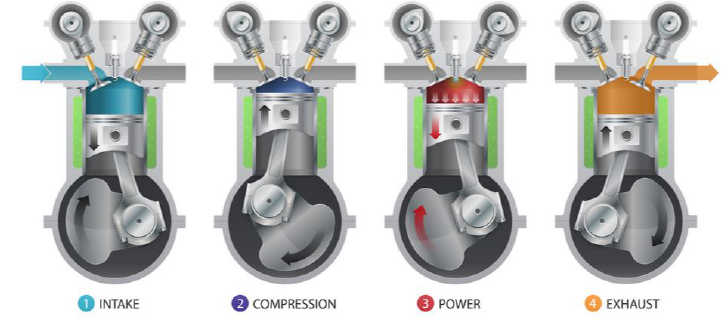
Figure 1. Four-stroke cycle engine